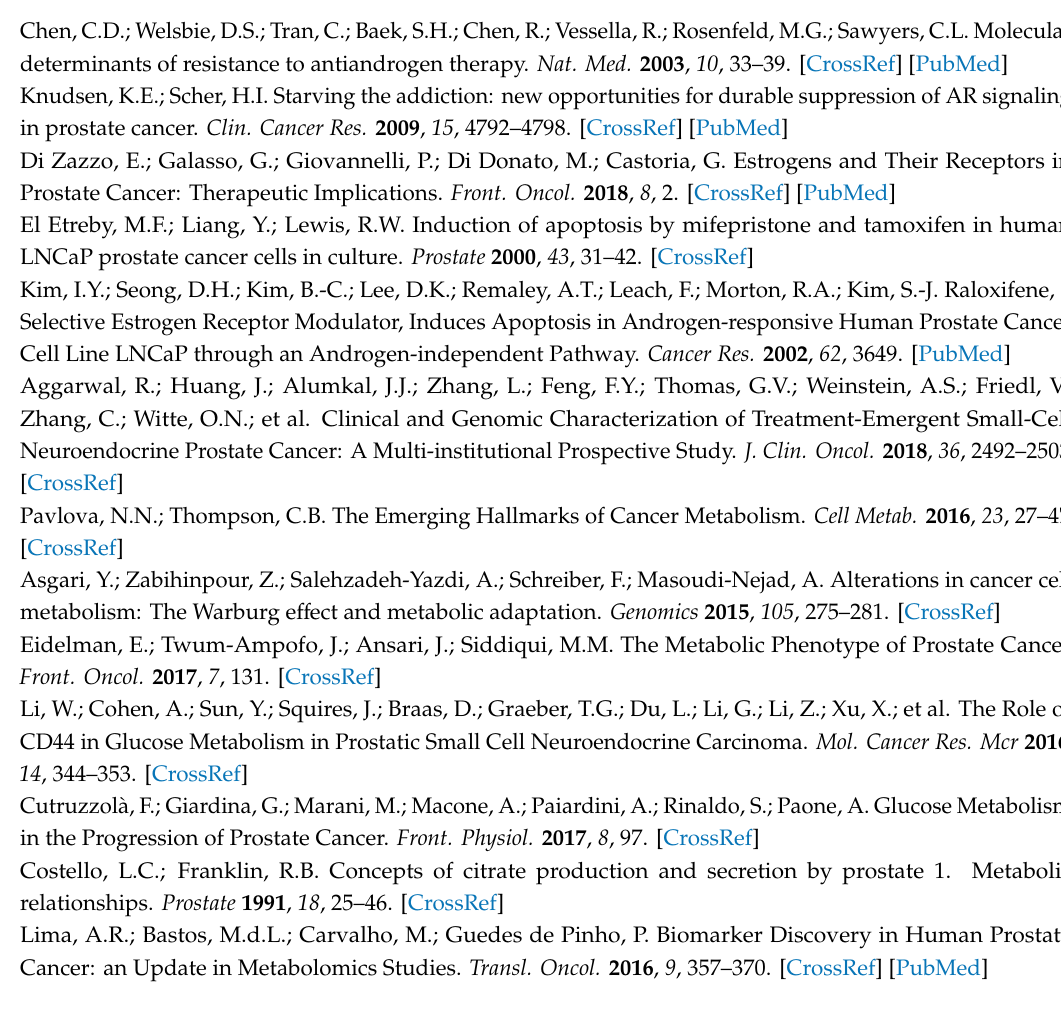
Table S1: Statistics of transcriptomics dataset, Table S2: Statistics of metabolomics and lipidomics dataset, Table S3: Upregulated gene sets in the LASCPC-01 cell line and SCNC patients, Table S4: Upregulated gene sets in the LNCAP cell line and prostate adenocarcinoma patients, Table S5: ChemRICH analysis of LASCPC-01 and LNCAP cell lines, Transcriptomics data were available at https: // figshare.com / s /